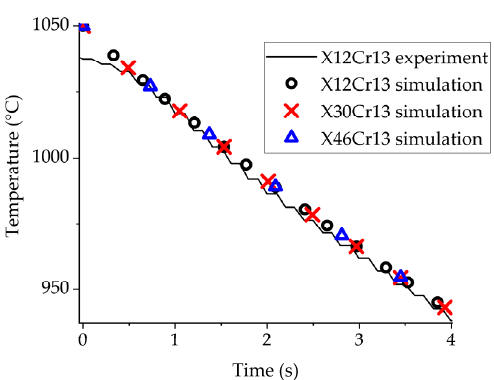
Figure 11. Comparison of the experimental and numerical simulated cooling curves of the X12Cr13 alloy from an austenitization temperature of 1050 °C. Simulated cooling curves of the X30Cr13 and X46Cr13 alloys are also shown in the comparison.